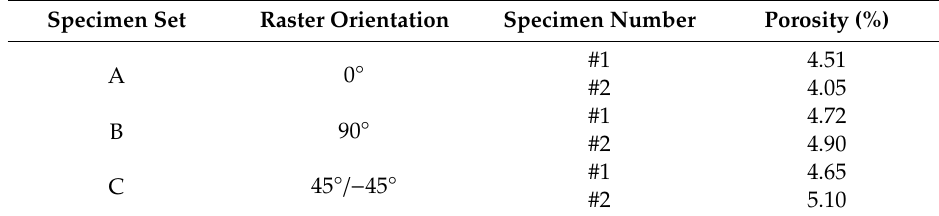
Table 4. Porosity results for specimens with various raster orientations and the extrusion width selected as 0.48 mm.